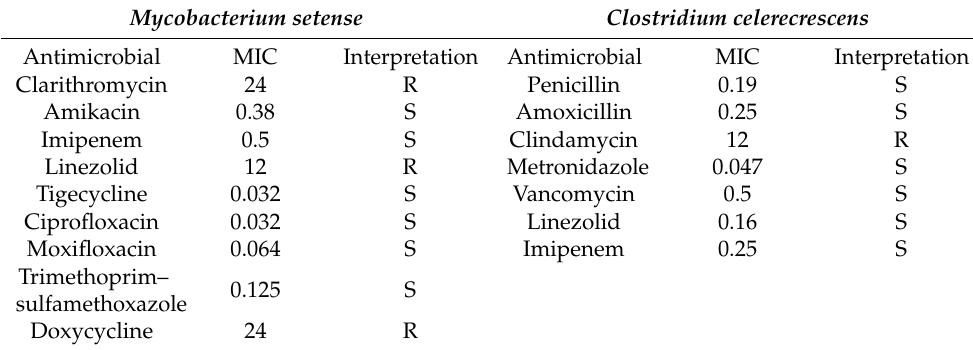
Table 1. Susceptibility profile and MIC values (mg/L) of Mycobacterium setense and Clostridium celerecrescens .